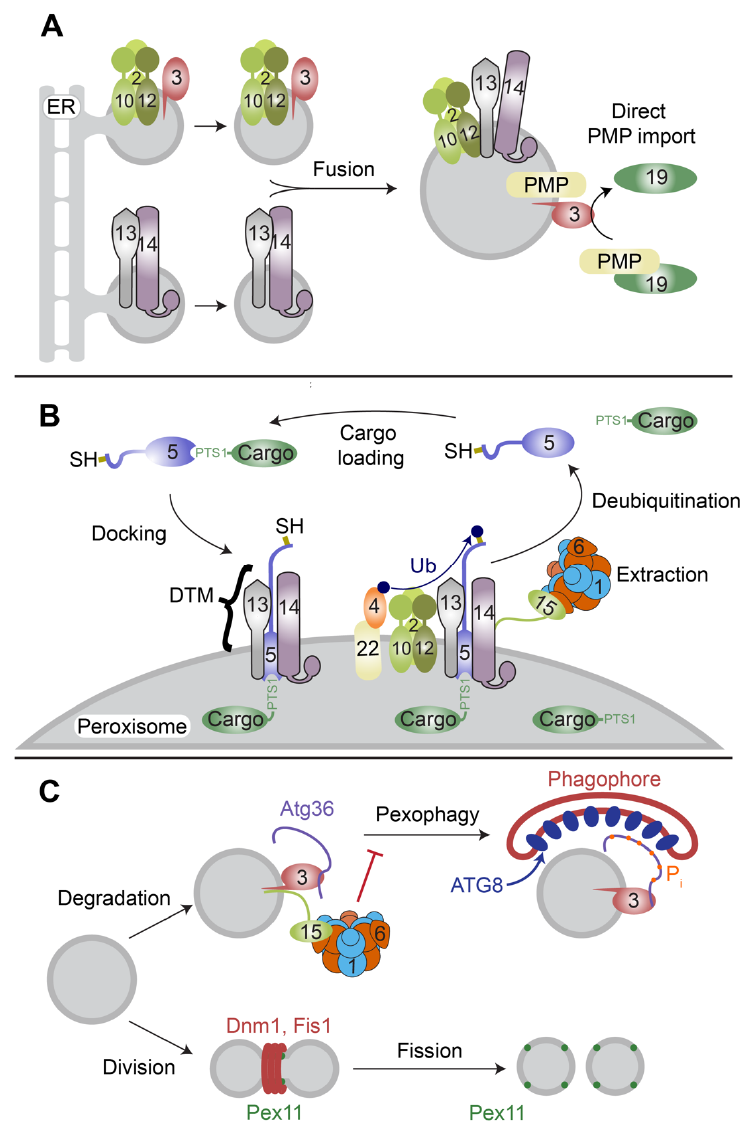
Figure 1. Overview of S. cerevisiae peroxisome biogenesis. ( A ) In de novo biogenesis, pre-peroxisomal vesicles (ppVs) carrying peroxisome membrane proteins bud and fuse with other ppVs or with mature peroxisomes. PMPs can also be directly inserted into the peroxisomal membrane by Pex19 and Pex3. ( B ) Pex5 binds the C-terminal PTS1-targeting signal on a cargo protein and interacts with the docking and translocation module (DTM) to import the cargo protein into the peroxisome. Pex5 is subsequently ubiquitinated by Pex4 and the Pex2/Pex10/Pex12 complex. Pex1/Pex6 extracts Pex5 from the peroxisomal membrane. Following deubiquitination, Pex5 can repeat the import cycle. ( C ) Mature peroxisomes can either grow and divide using the peroxisomal fission factor Pex11 and shared mitochondrial factors (Dnm1 and Fis1) or undergo peroxisome-specific autophagy mediated by adaptors such as Atg36. Pex1/Pex6 interacts with Atg36 through Pex3 and Pex15 to suppress Atg36 phosphorylation and pexophagy. Accessory proteins involved in process are represented as numbered